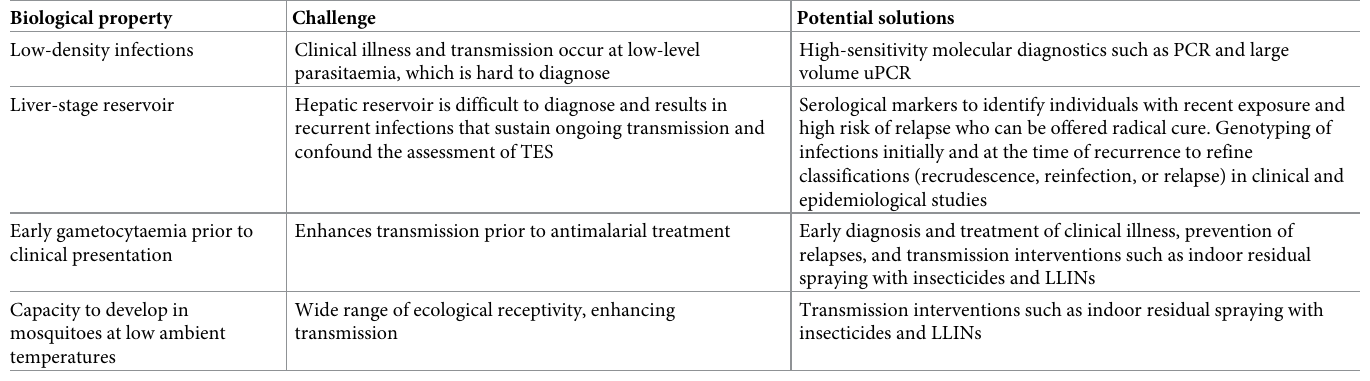
Table 1. Biological properties of P . vivax that enhance the capacity for transmission and